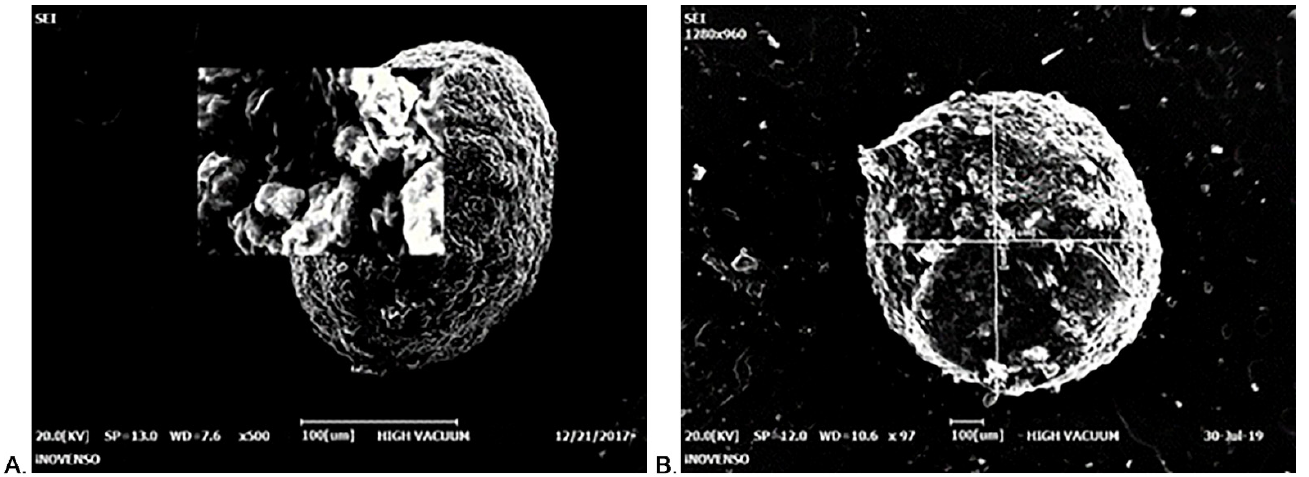
Figure 1. ESEM imaging: ( A ) CS microparticle; ( B ) CS-Gli-Sil microparticle.